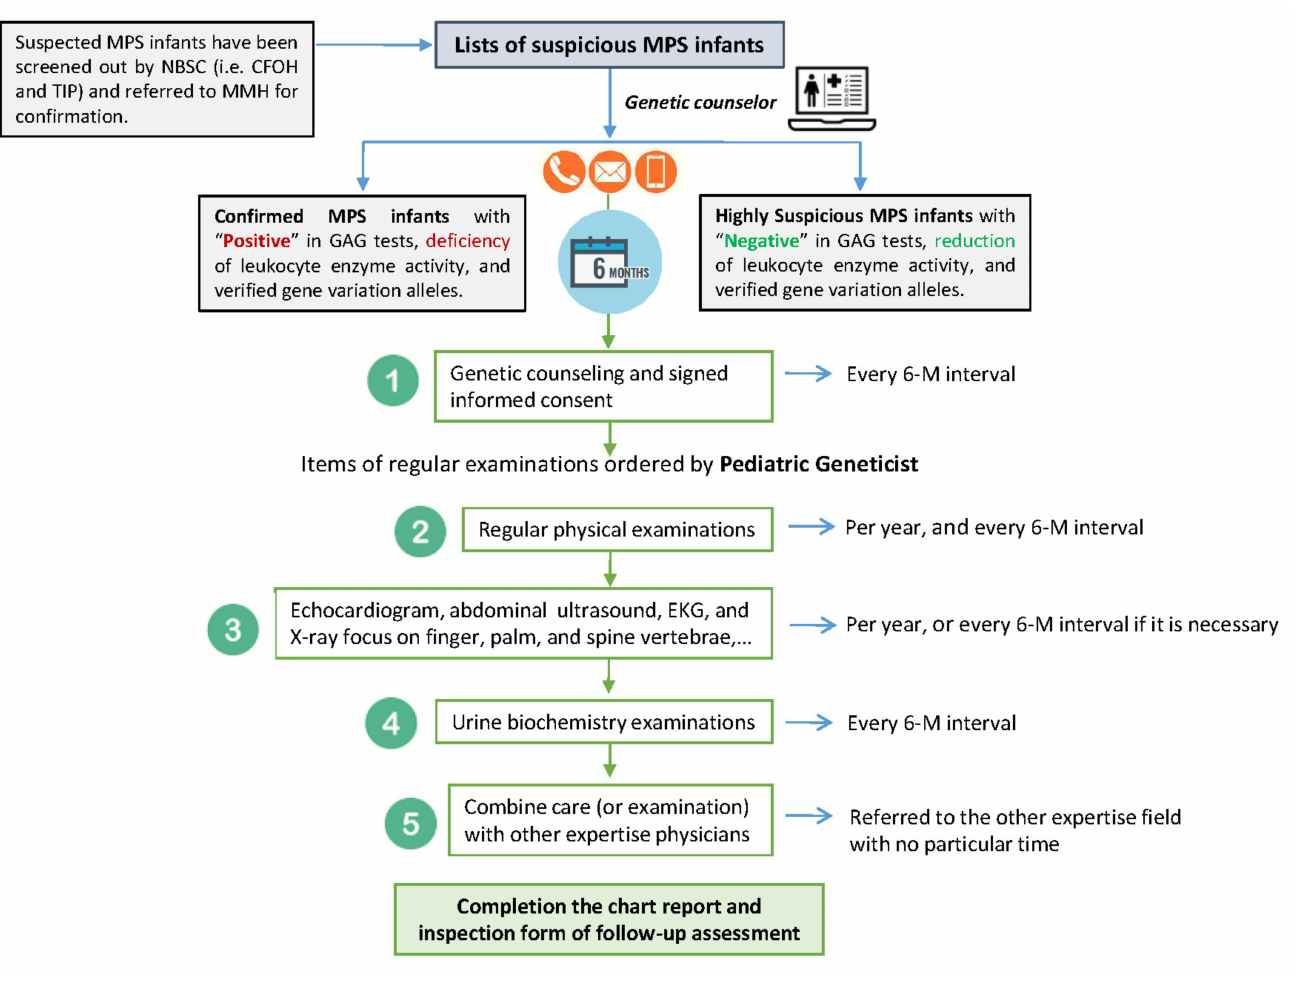
Figure 3. The standard operation procedures of the intensive follow-up management protocol for the infants with confirmed MPS and those highly suspected of having